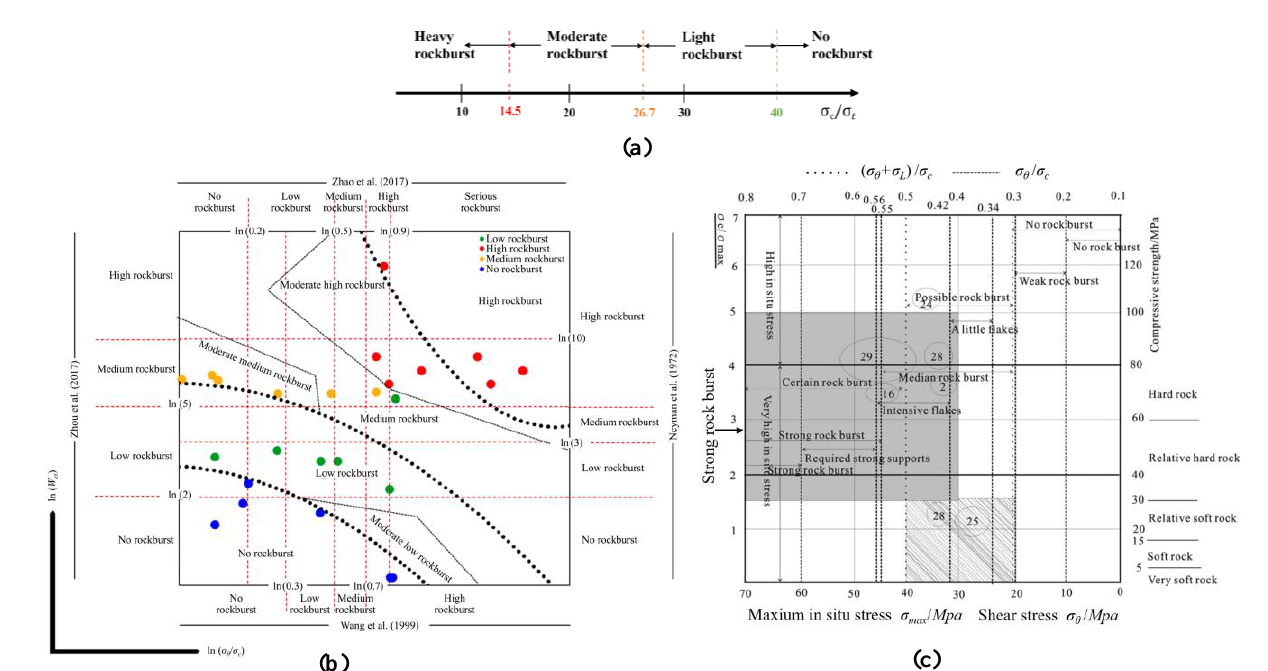
Figure 8. Rockburst charts: ( a ) one-dimensional rockburst chart: the rockburst intensity diagram represented by σ c / σ t (from [93]); ( b ) two-dimensional rockburst chart: performance of the TRC chart and the empirical formulas used to determine the rockburst intensity as compared to the observed values (from [18]); ( c ) diagrammatic explanation of limit values for prediction of rockburst and squeezing from different aspects (from [167]).